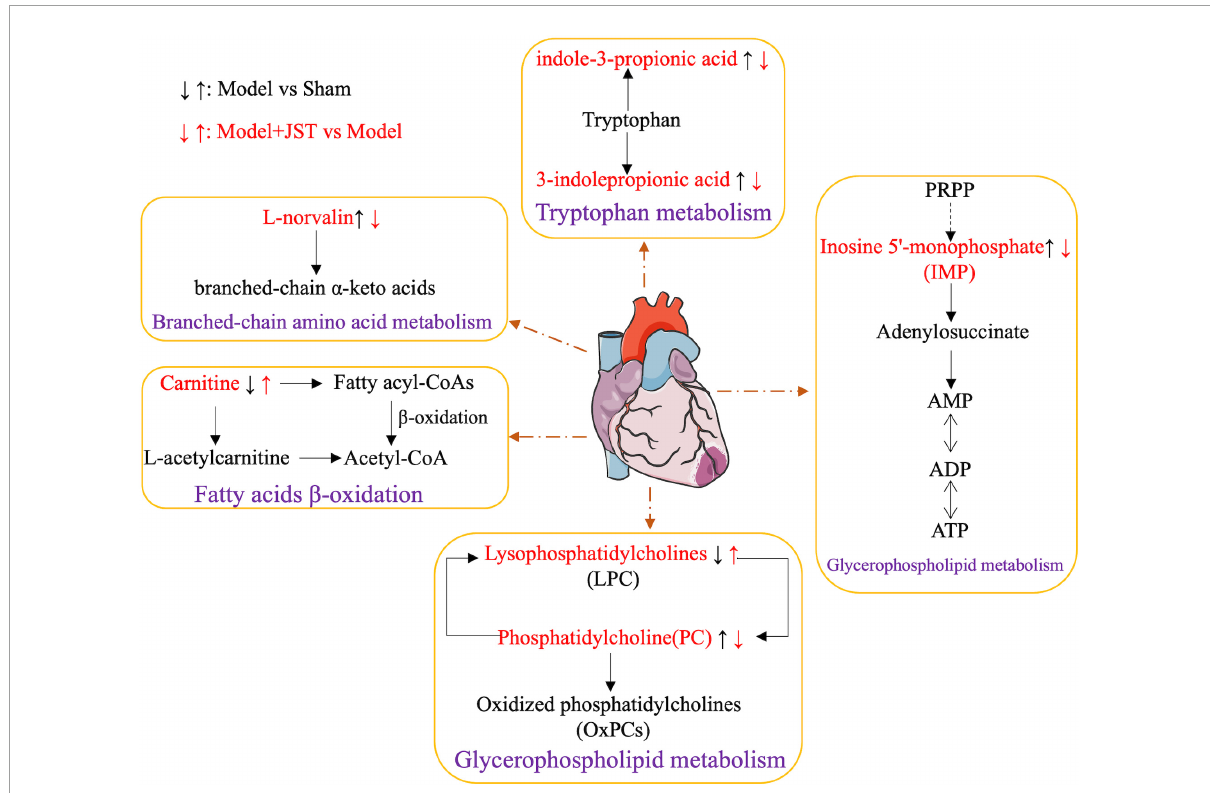
FIGURE7 Network of the potential biomarkers associated with heart failure. The metabolites written in red are identified as potential biomarkers. “ ↑ ” represents upregulation, “ ↓ ” represented